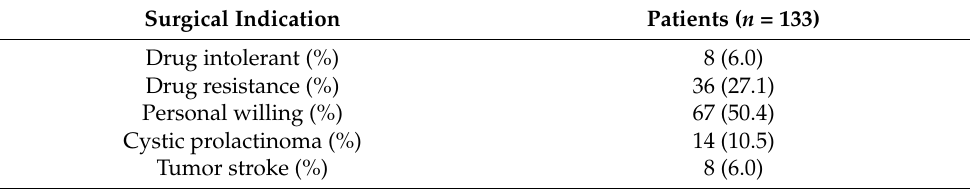
Table 1. Surgical indications for 133 female patients with